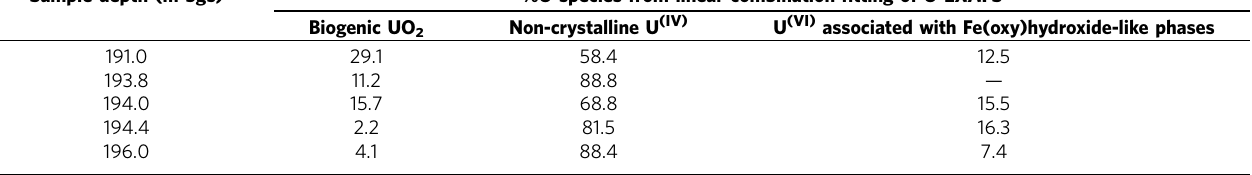
Table 1 | Bulk U EXAFS analysis. Sample depth (m-bgs)